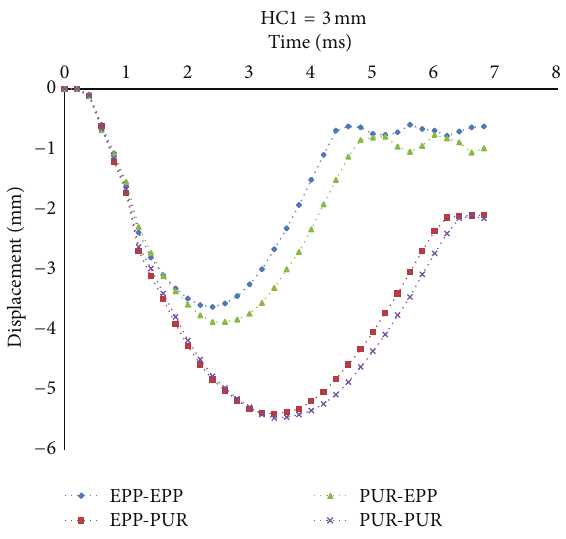
Figure 7: Local displacement at Node B with HC1 = 3 mm in four cases of